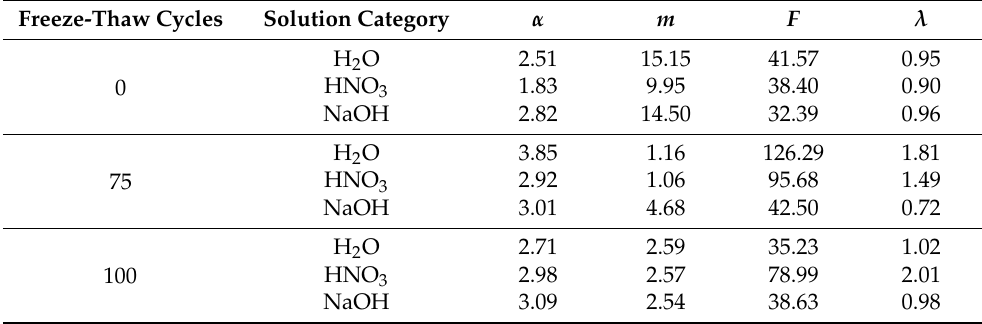
Table 3. Parameter values of constitutive model under different chemical solutions and freeze-thaw cycles. Freeze-Thaw Cycles Solution